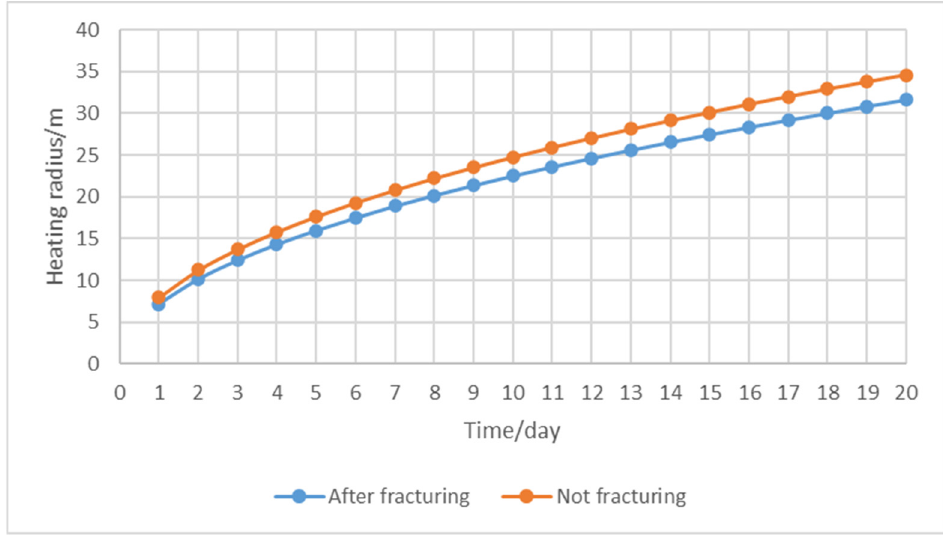
Figure 2. Curve of heating radius with time.